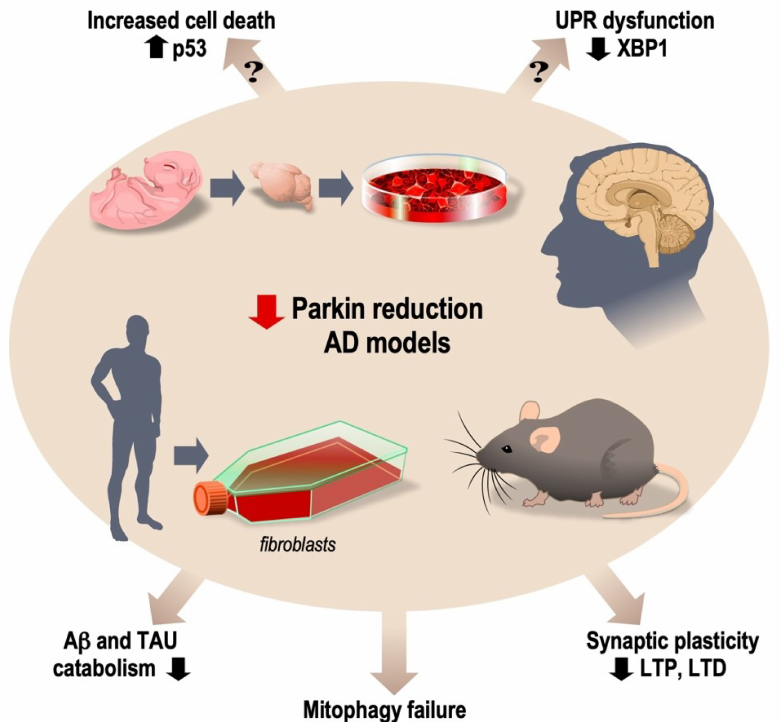
Figure 1. Influence of parkin reduction in XBP1S-linked unfolded protein response (UPR), p53- dependent cell death, long-term potentiation and long-term depression (synaptic plasticity), mi- tophagy, catabolism of A β and Tau proteins in mouse primary cultured neurons as well as in AD-affected human fibroblasts and sporadic AD-affected